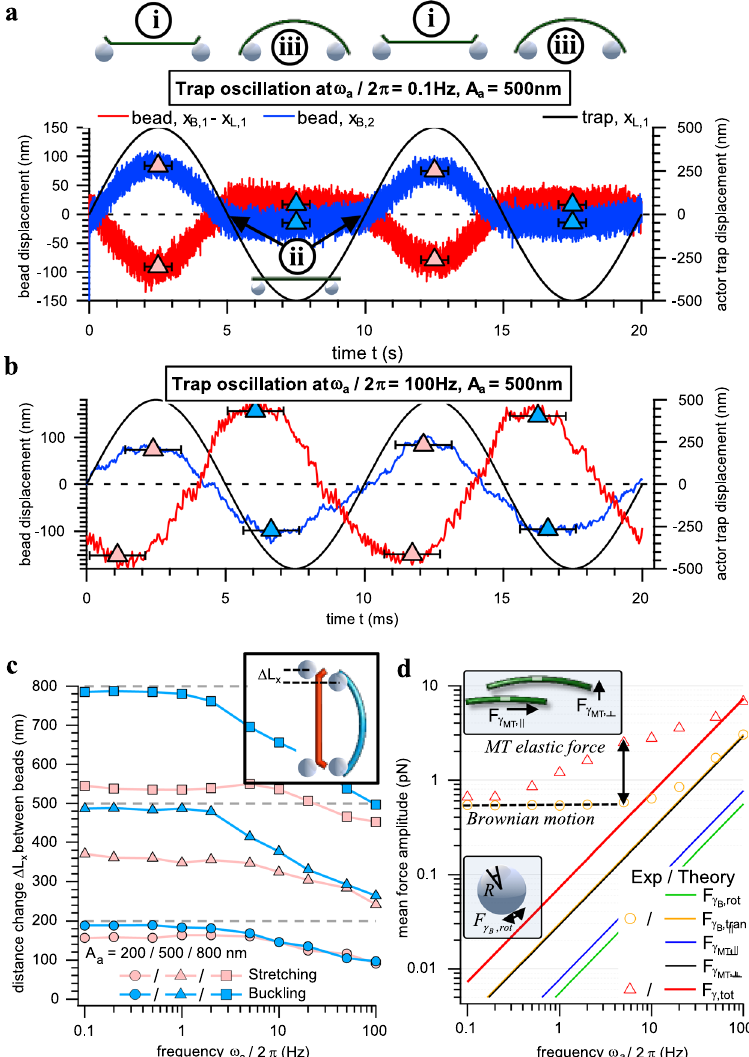
Figure 2. Frequency dependent response of a single microtubule filament – bead construct (L = 5 µ m). ( a ) and ( b ) Two periods of the relative actor and sensor bead displacements x B1 ( t ) − x L 1 ( t ) and x B 2 ( t ) − x L 2 ( t ) from their trap centers during oscillations of the actor trap x L 1 ( t ) = L /2 + A a sin( ω a t ) and the static sensor trap x L 2 ( t ) = − L /2 at A a = 500 nm and ω a /2 π = 0.1 Hz ( a ), or ω a /2 π = 100 Hz ( b ), respectively. Markers indicate the maximum amplitude x max 1 and x max 2 of both beads during each half period. ( c ) Frequency dependence of the maximum amplitude Δ L x = A a − x max 1 − x max 2 between both beads during stretching and buckling averaged over several oscillation periods. ( d ) Theoretical mean amplitudes of the involved viscous forces (solid lines) compared to the experimentally obtained sum of all acting forces (markers) for a single trapped bead (yellow) and the filament – bead construct